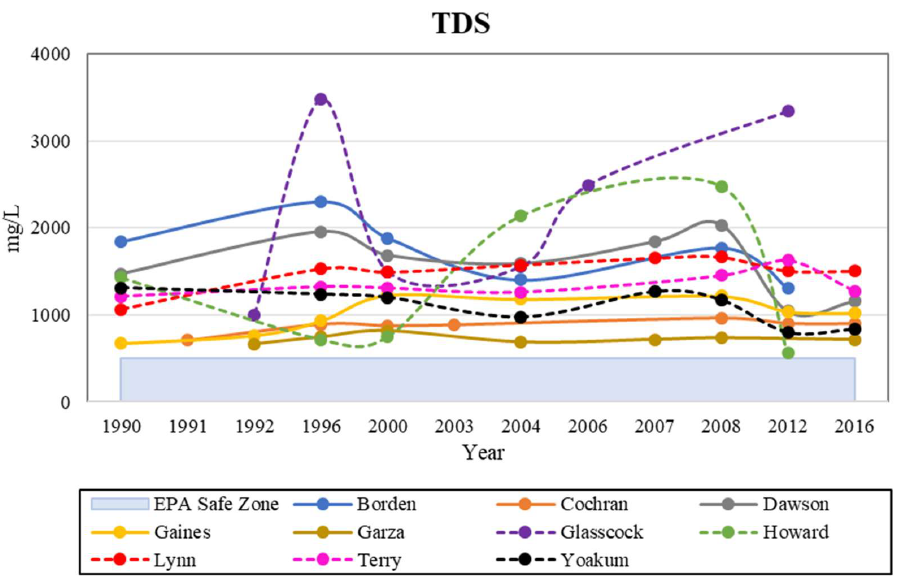
Figure 10. Historical analysis of TDS levels in the study area, with the EPA safe zone indicated.